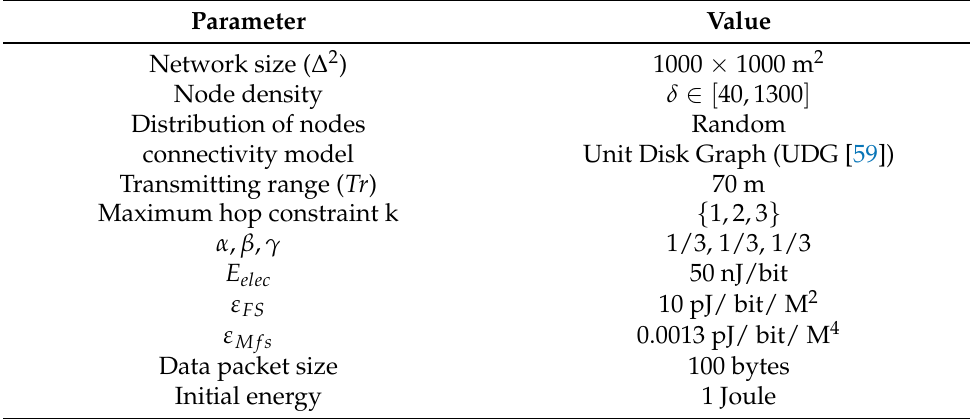
Table 4. Simulation parameters used in the experiment